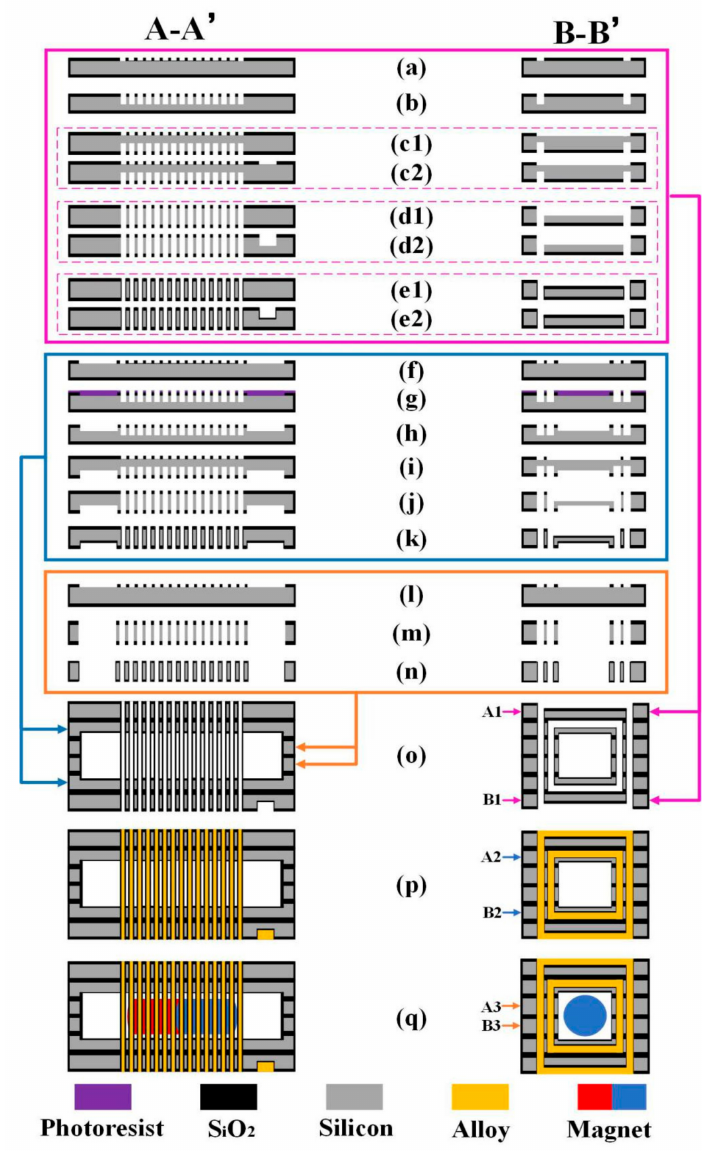
Figure 3. Fabrication process of the silicon-chip based solenoid. The (A-A’) and (B-B’) cross sections are defined in Figure 1b. ( a – e2 ) Formation of the grooves and vias of the outer-layer coil (for the silicon mold layers of A1 and B1); ( f , g ) formation of the vias of inner-layer coil (for A2 and B2); ( h ) etching to form the channel for the sliding magnet; ( i , j ) etching to form the inner-layer-coil grooves; ( k ) oxidation to insulate the surface mold; ( l – n ) etching and oxidation for the middle support layers (for A3 and B3); ( o ) stacking the six silicon layers to form the whole mold for metal casting; ( p ) formation of the solenoid by ZnAl-alloy casting and cooling; ( q ) inserting cylindrical